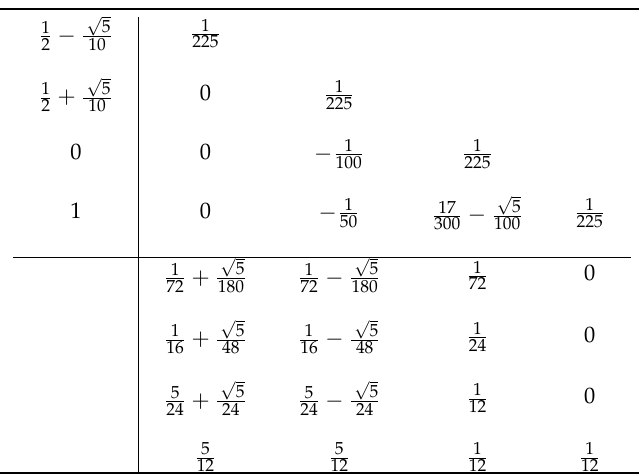
Table 3. The DIRKT6